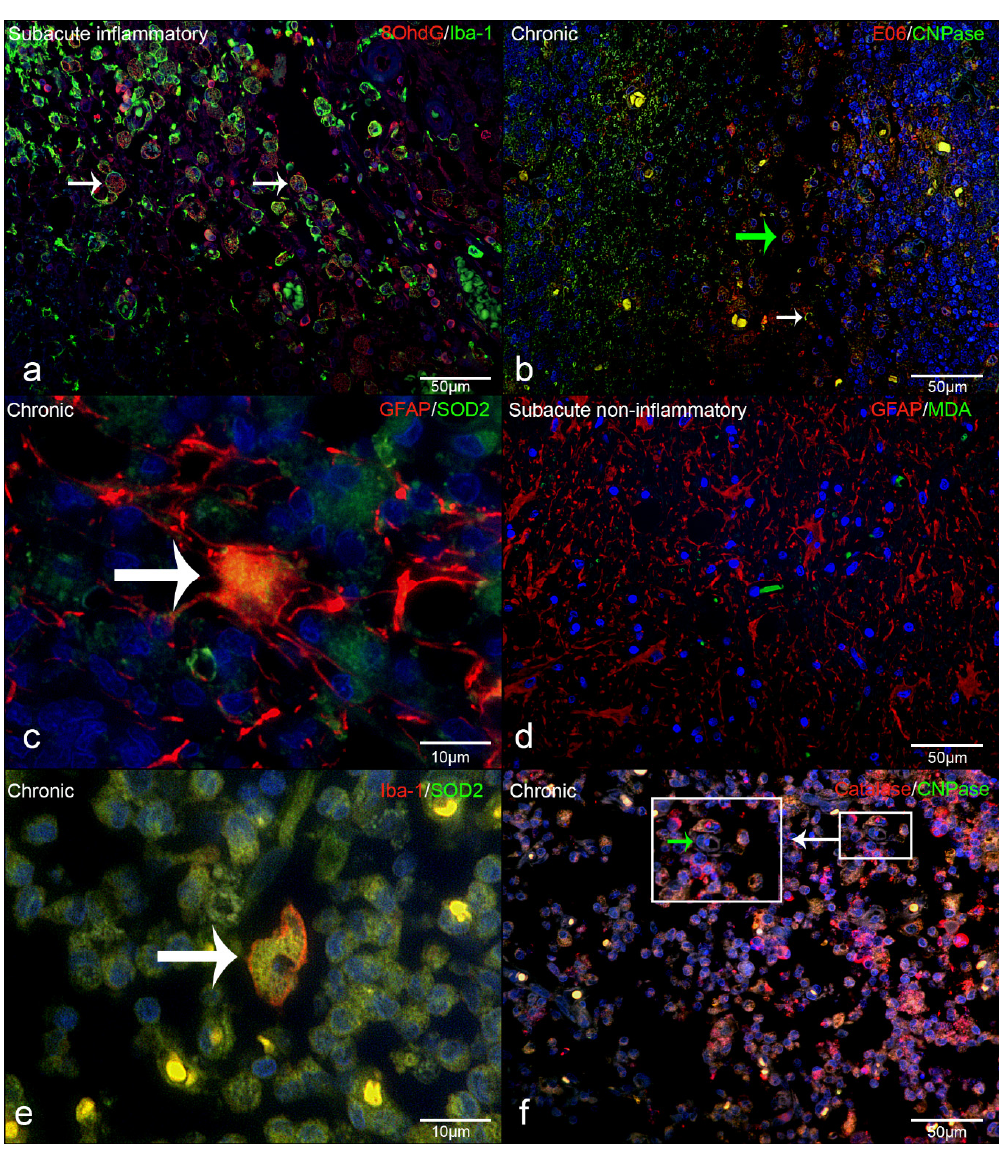
Figure 4. Immunofluorescence in CDV-DL lesions: ( a ) 8OHdG and Iba-1 as well as macrophages/microglia that are positive for 8OHdG (double labeling, yellow, arrow, ( b ) Oxidized phospholipids (clone E06) and CNPase as well as oligodendrocytes positive for oxidized phospholipids (double labeling, yellow, white arrow) as well as in cells with macrophage morphology (green arrow), ( c ) SOD2 and GFAP showing astrocytes positive for SOD2 (double labeling, yellow, arrow), ( d ) MDA and GFAP (red) double labeling (yellow) showing that astrocytes do not significant co-localize with MDA, ( e ) SOD2 and Iba-1 as well as macrophages/microglia positive for SOD2 (double labeling, yellow, arrow), ( f ) Catalase and CNPase, showing that oligodendrocytes can be positive for catalase (double labeling, yellow, green arrow within the insert).